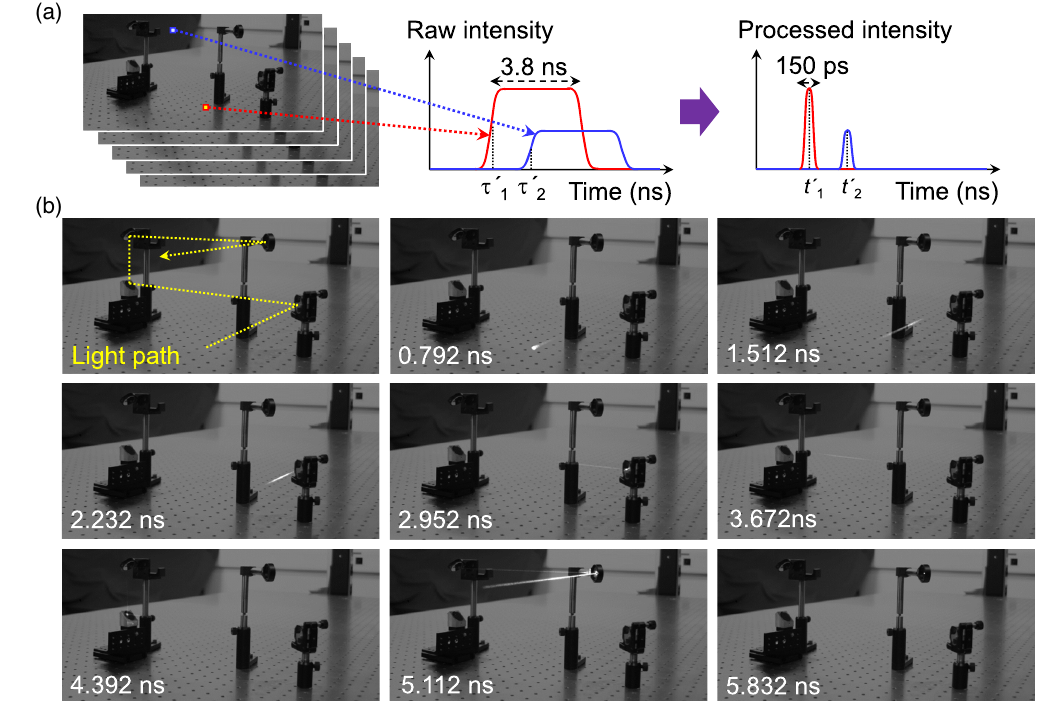
FIG. 2. Video generation of three-dimensional light-in-flight imaging. (a) Data processing flow for generation of light-in-flight video. (b) Laser pulse propagating over time, shown along the dashed line in the top-left image. Superluminal motion of the laser pulse is observed in the latter frames. The light-in-flight video is taken under dark conditions, and each frame is superimposed with a 12-bit two-dimensional intensity image independently taken with the same SPAD camera under room light. The image resolution is 1024 × 500